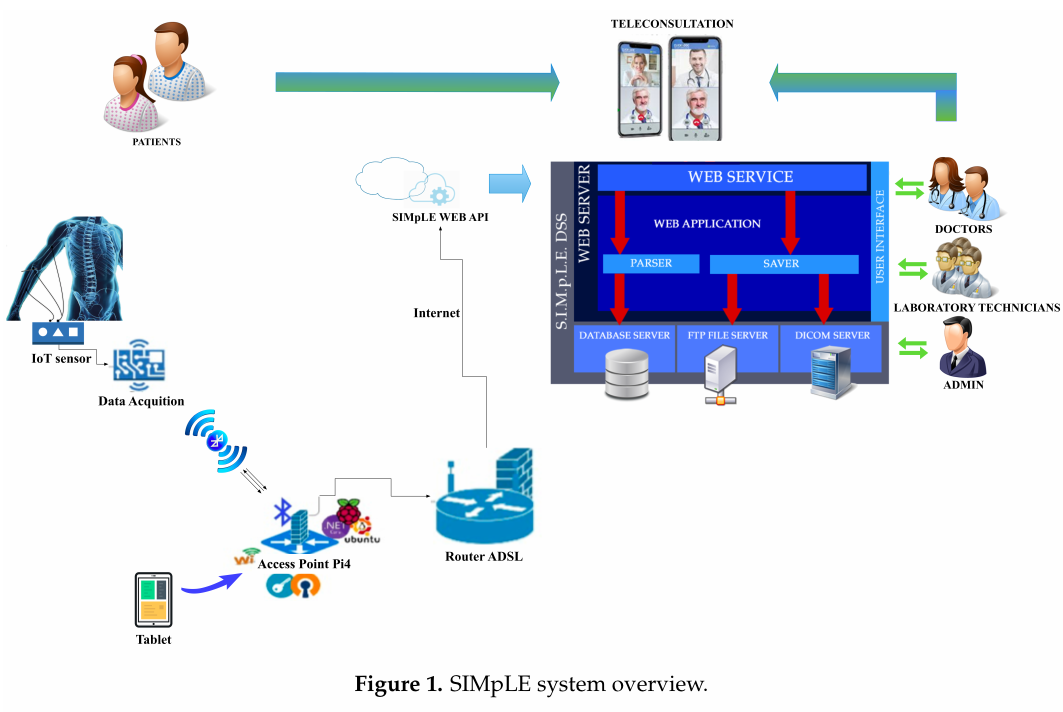
Figure 1. SIMpLE system overview.